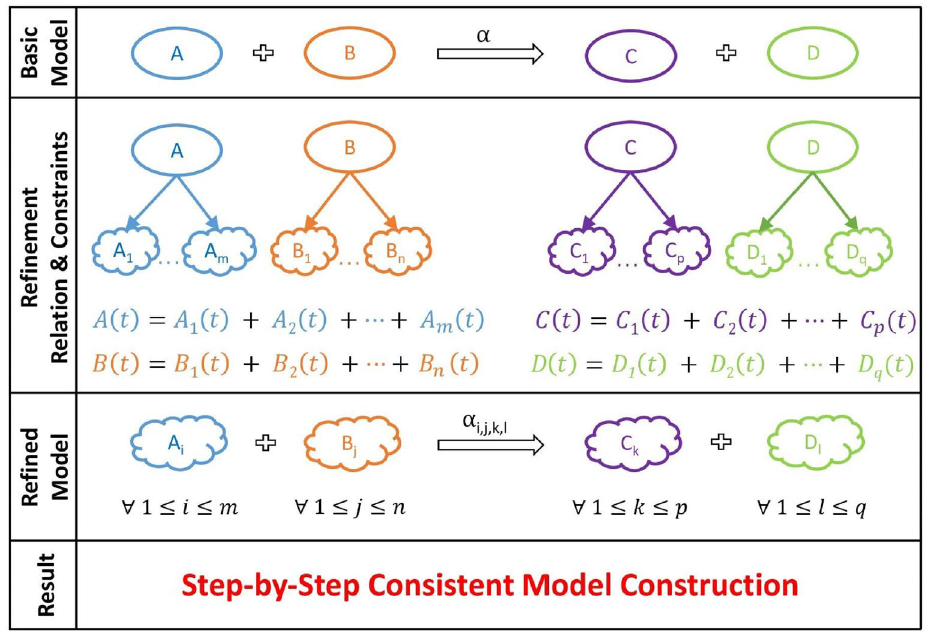
Figure 1. The step-by-step refinement-based approach to building a reaction network model. (Basic Model) We start with a simplified, abstract version of the model. (Refinement) We then gradually add details to the variables of the model. (Refined model) This leads to a more detailed, refined version of the reactions of the model. (Refinement constraints) The refined model is set up to ensure its consistency.